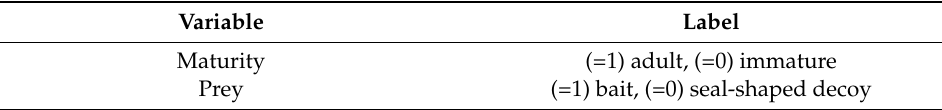
Table 1. Description of variables. Own